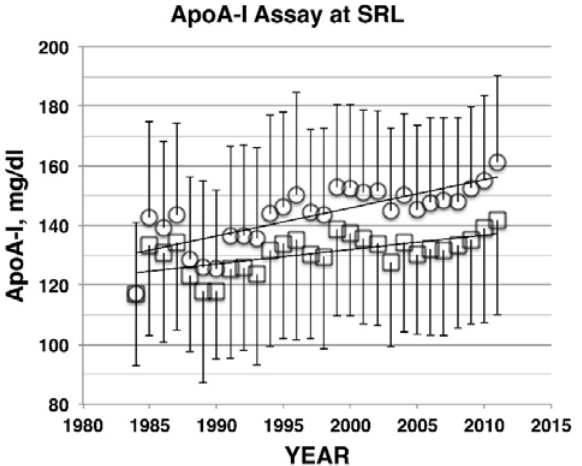
Figure 2. Apolipoprotein A-I (ApoA-I) measured commercially in the SRL laboratory, mean ± SD, for male (squares) and female (circles). The slopes are 0.485 mg/dL/year and